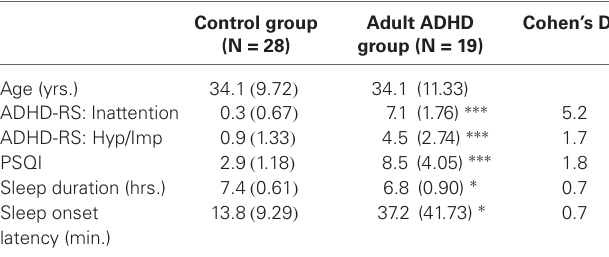
Table 1 | Differences between the control group and adult ADHD group on ADHD and sleep complaints .